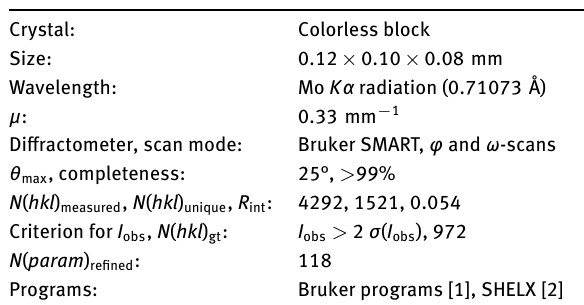
Table 1: Data collection and handling.